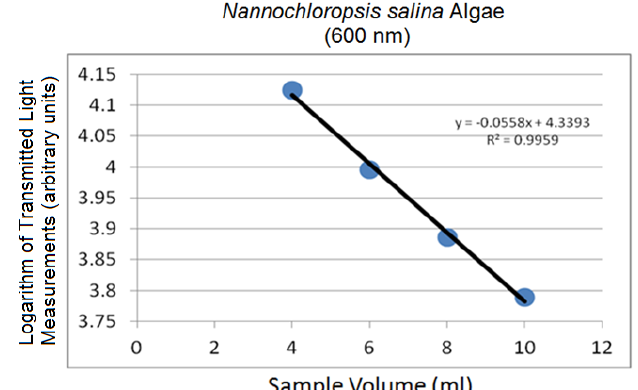
Figure 11. Logarithm of 600 nm spectral peak ( Nannochloropsis salina ) at different sample